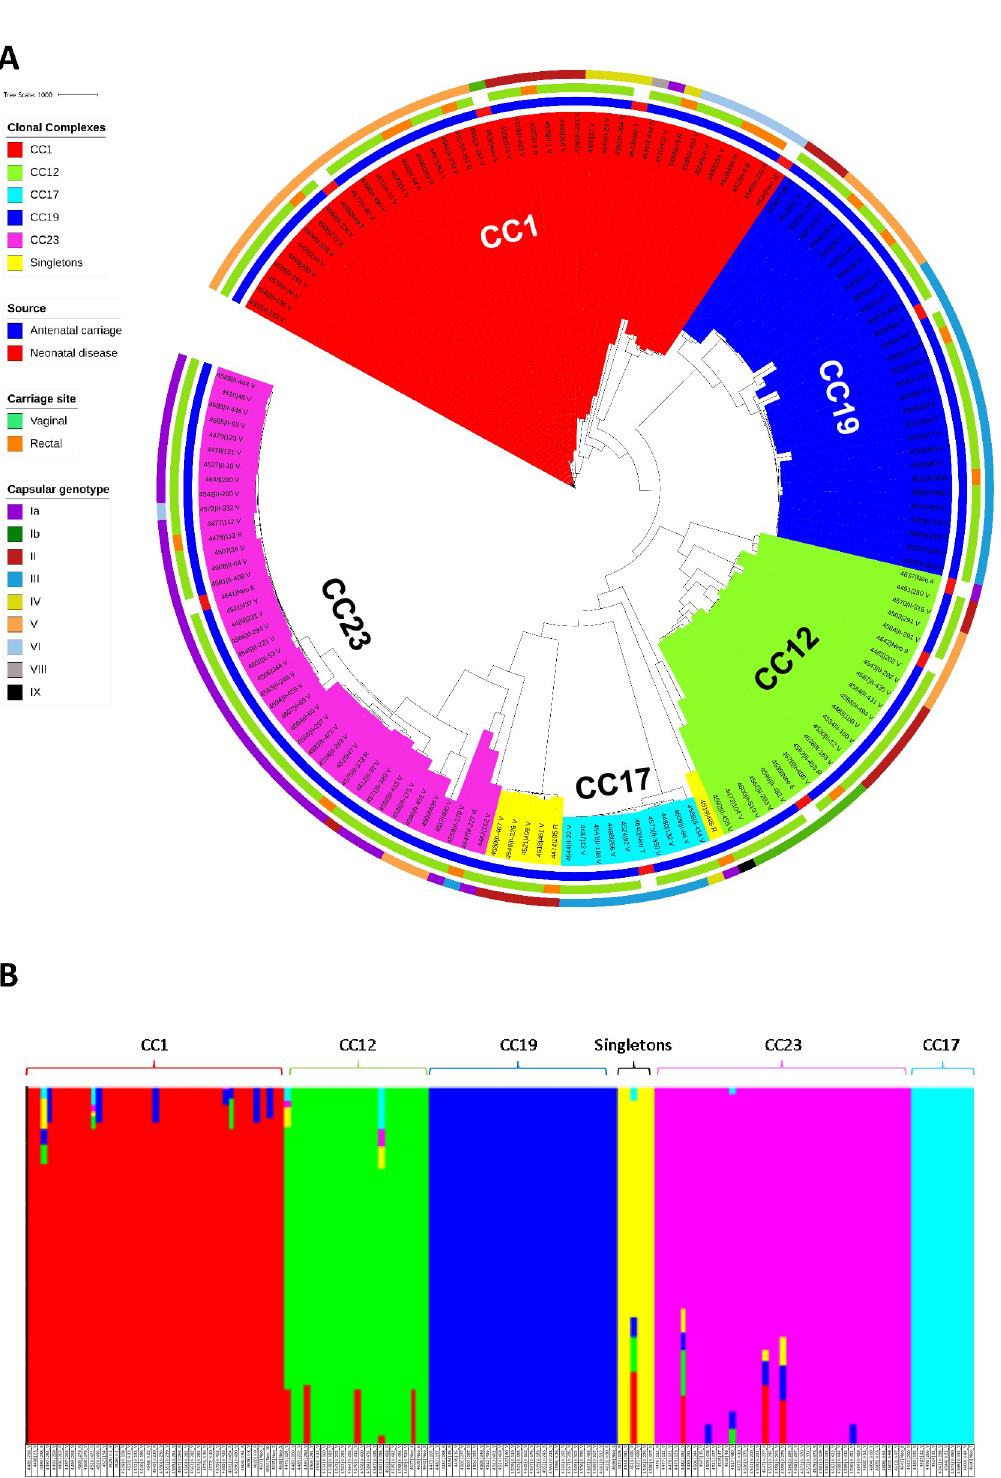
Fig 1. (A) The core genome maximum likelihood phylogeny of 151 clinical Streptococcus agalactiae isolates collected from Western Australian pregnant women (n = 141) and neonates (n = 10). Clonal complexes are highlighted within the tree. The first colour strip indicates antenatal carriage (blue) and neonatal invasive disease (red) isolate origins. The central colour strip indicates carriage site for the antenatal isolates, either vaginal (green) or rectal (orange) and the outer colour strip indicates the capsular genotype (Ia–IX). (B) Admixture analysis of population structure of the same S . agalactiae